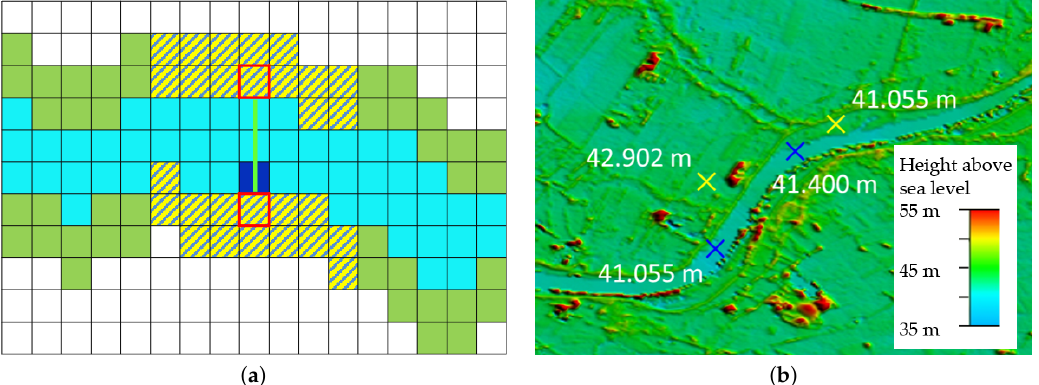
Figure 12. ( a ) Basic principle for the determination of the river bed height. Light blue is the river mask, dark blue pixel which height is being estimated, yellow striped are the pixels in which heights are considered. ( b ) Exemplary result of the river editing procedure by the river Elbe, Germany. The blue crosses indicate the water heights, while the yellow ones indicate the heights over